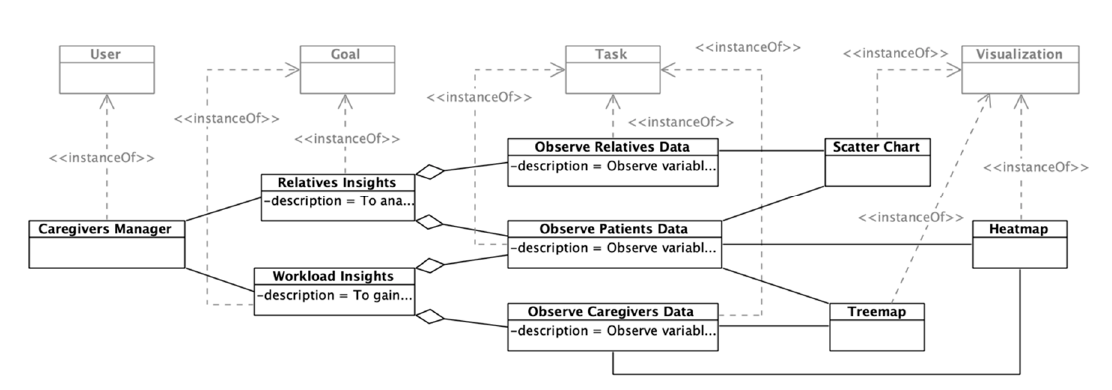
Figure 4. Dashboard meta-model instantiation regarding the user goals and tasks.